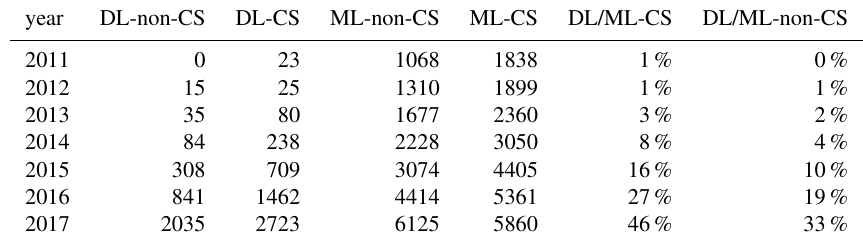
Table 1. Number of papers returned from searches on ISI Web of Science. year DL-non-CS DL-CS ML-non-CS ML-CS DL/ML-CS DL/ML-non-CS 2011 0 23 1068 1838 1% 0% 2012 15 25 1310 1899 1% 1% 2013 35 80 1677 2360 3% 2% 2014 84 238 2228 3050 8% 4% 2015 308 709 3074 4405 16% 10% 2016 841 1462 4414 5361 27% 19% 2017 2035 2723 6125 5860 46% 33% DL-CS results were obtained by searching for “topic” (TS) = “deep learning”, “and”, “research area” (SU) = “computer science”; ML-CS was obtained the same way as DL-CS, only that “deep learning” was replaced by “machine learning”; DL-non-CS was obtained by TS = “deep learning” not SU = “computer science” not SU = education. Education was removed because entries in this category were not related to our definition of DL. There were also 19 articles in 2011 where deep learning was about education in disciplines other than SU = Education. Therefore, 19 was used as a blank value and also subtracted from the DL-non-CS column. DL/ML-CS is ratio of DL-CS to ML-CS expressed as a percentage. DL/ML-non-CS was obtained